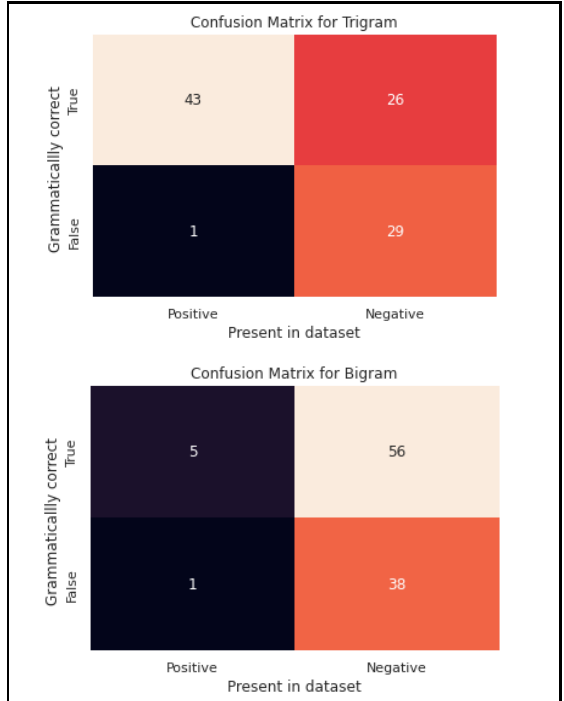
Fig 6.1 Confusion Matrix for Trigram and